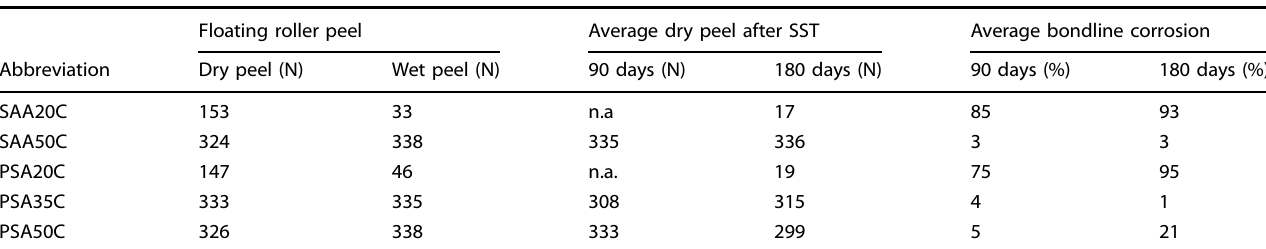
Table 2. Summary of the mechanical performance of the selected oxides Floating roller